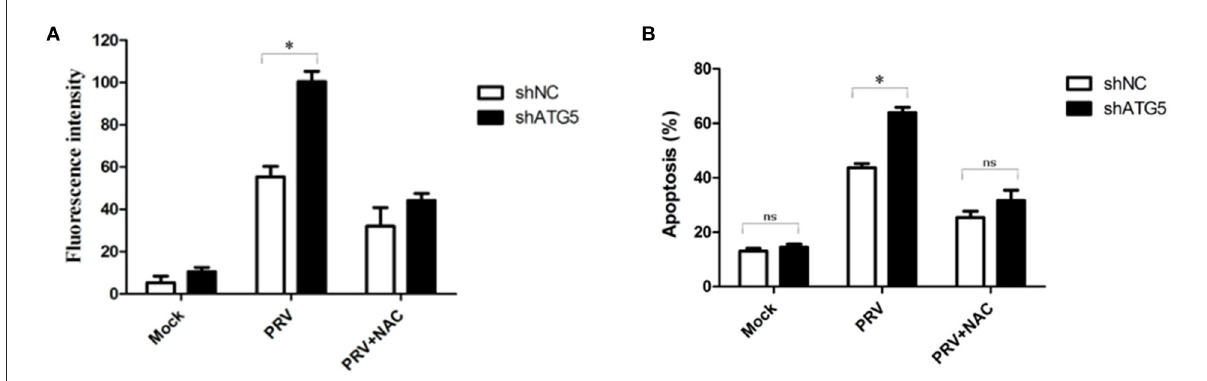
FIGURE6 ROS expression mediates PRV-induced apoptosis in autophagy-suppressed cells. (A) PK-15 cells were transfected with shATG5 and shNC for 24h and then infected with PRV. NAC was added at the infection time to eliminate ROS. ROS level was measured with DCFH-DA as previously described. The level of ROS was tested by flow cytometry. (B) The cells were treated as (A) , and then analyzed by flow cytometry to detect the levels of apoptosis. The data represent the mean ± SD of three independent experiments and are analyzed by two-way ANOVA, * P < 0.05.